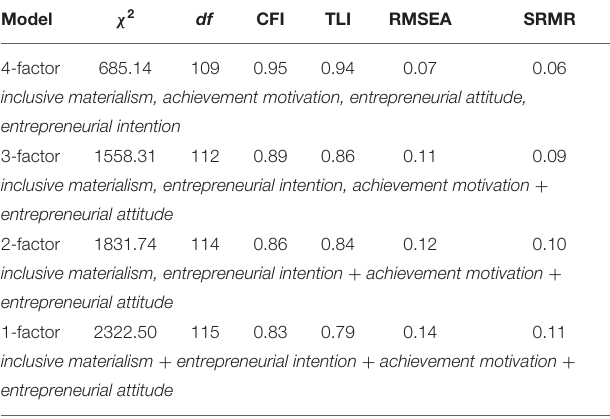
TABLE 2 | Results of confirmatory factor analyses (CFA). Model